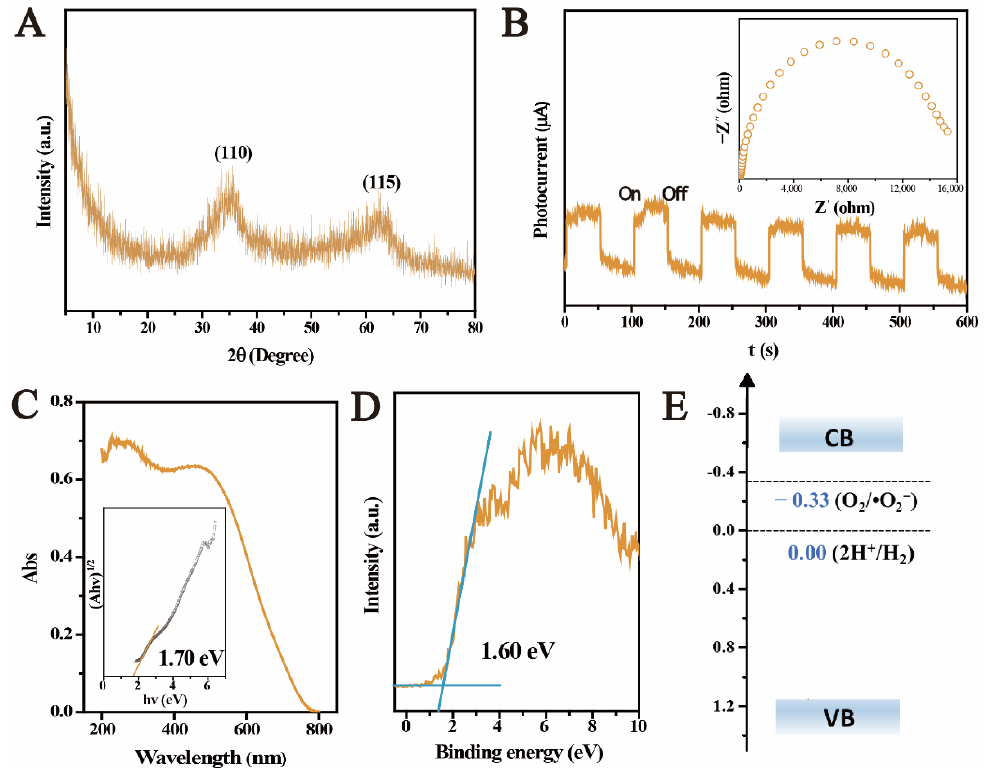
Figure 1. Physicochemical properties of ferrihydrite, XRD pattern ( A ), time-dependent photocurrent measurement and EIS (inset) ( B ), UV–Vis diffuse reflectance spectra ( C ) and the optical band gap energy (inset), valence band X-ray photoelectron spectroscopy (VB-XPS) ( D ), and the band edge positions ( E ).